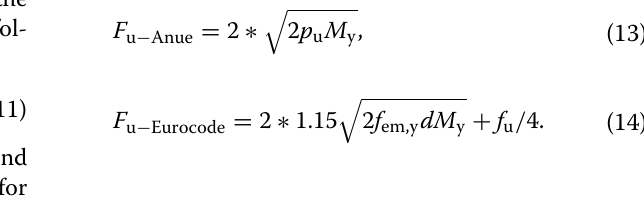
Table 2 Comparisons of predicted and observed values at critical points Critical load Model Eq. F pl − 1 F y − 1 F pl − 2 F y − 2 F u Yield II The values in parentheses are coefficient of variance